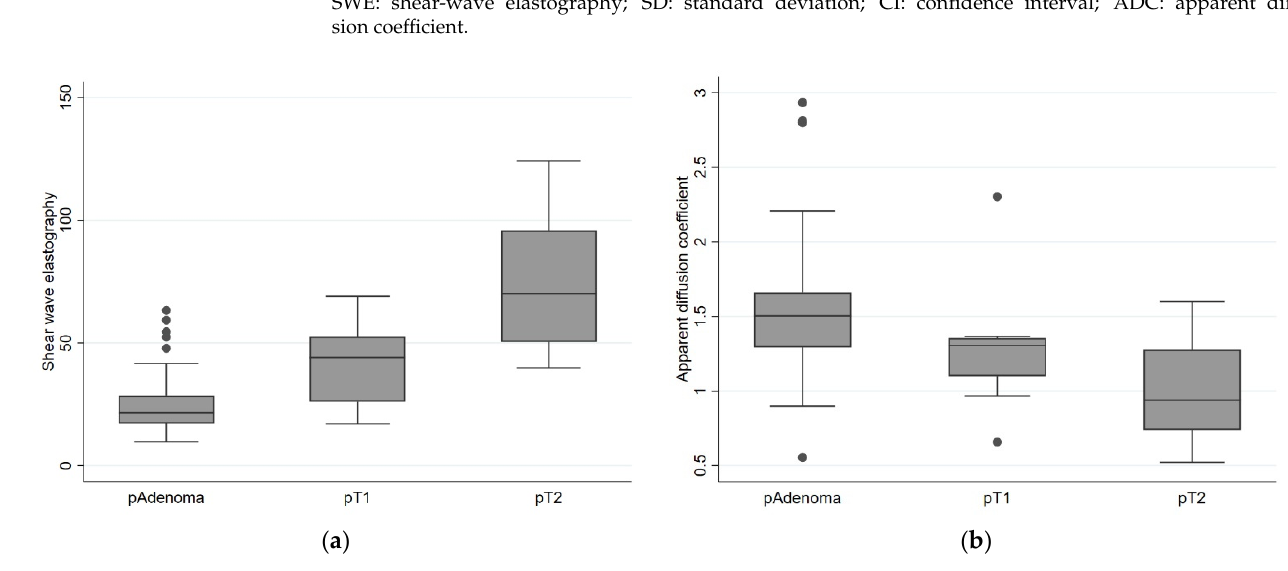
Figure 4. Box plot showing means with percentiles and outliers for pAdenomas, pT1, and pT2 tumors of: ( a ) Shear-wave elastography in kilopascal (kPa) with a difference between the means with a chi 2 of 16.15 and a p -value of <0.001; ( b ) apparent diffusion coefficient in 10 − 3 mm 2 /s with a chi 2 of 1.29 and a p -value of